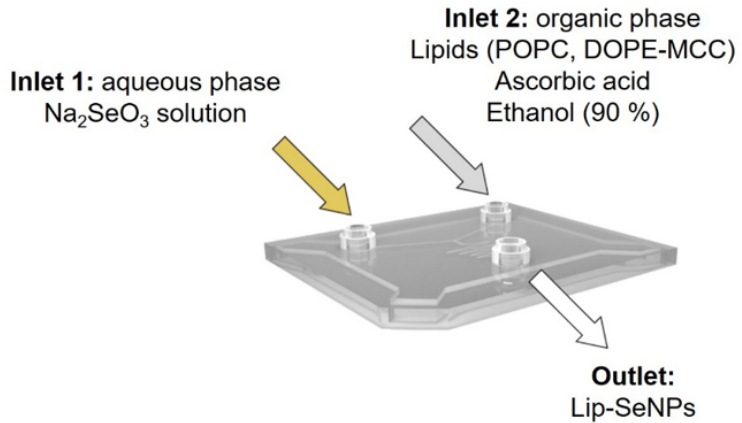
Figure 1. Scheme of the microfluidic cartridge used for the simultaneous chemical reduction and assembling process of SeNPs loaded liposomes. The components for the synthesis were injected into the inlets as shown above; through the outlet, Lip-SeNPs were obtained. A flow ratio of 2.5:1 aqueous phase to organic phase and a flow rate of 5 mL/min were used.